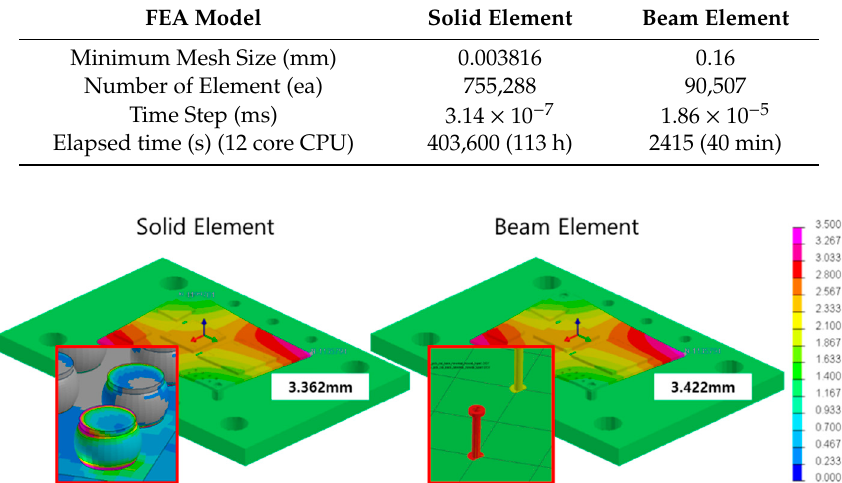
Figure 17. Time response of the tensile strain for all fixtures.